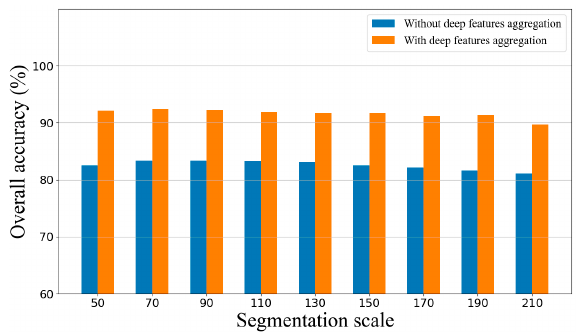
Figure 21. Overall accuracies with or without deep feature aggregation.